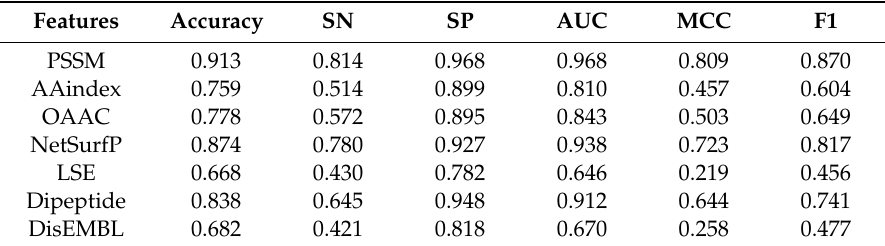
Table 1. Performance of classification models derived from different types of features